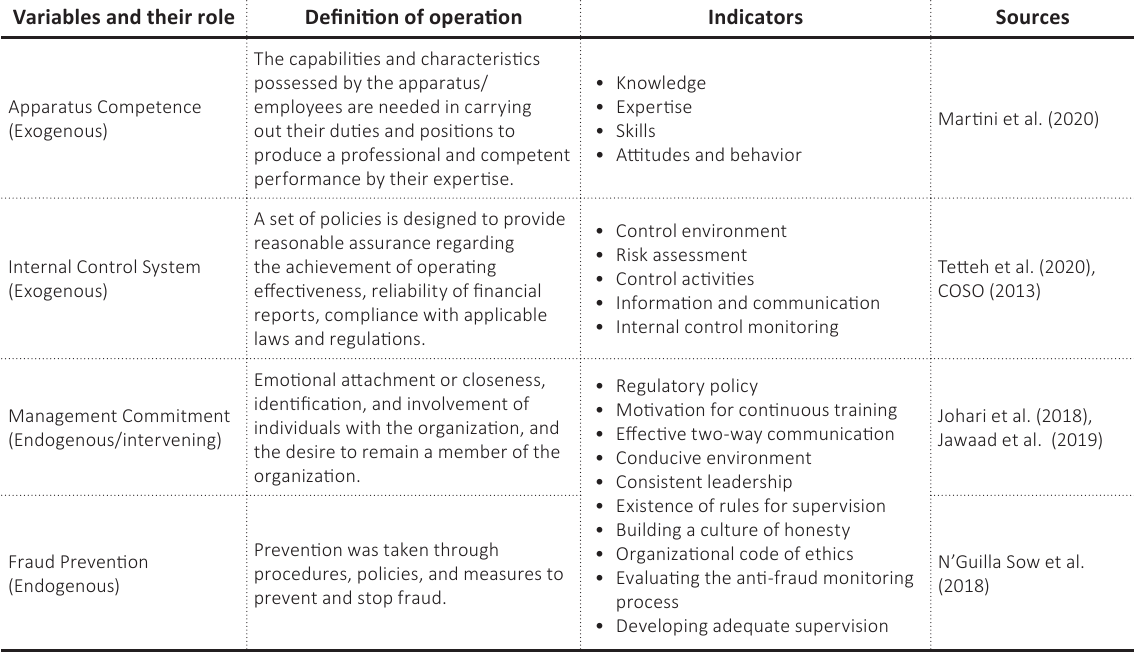
Table 2. Operationalization of research variables Variables and their